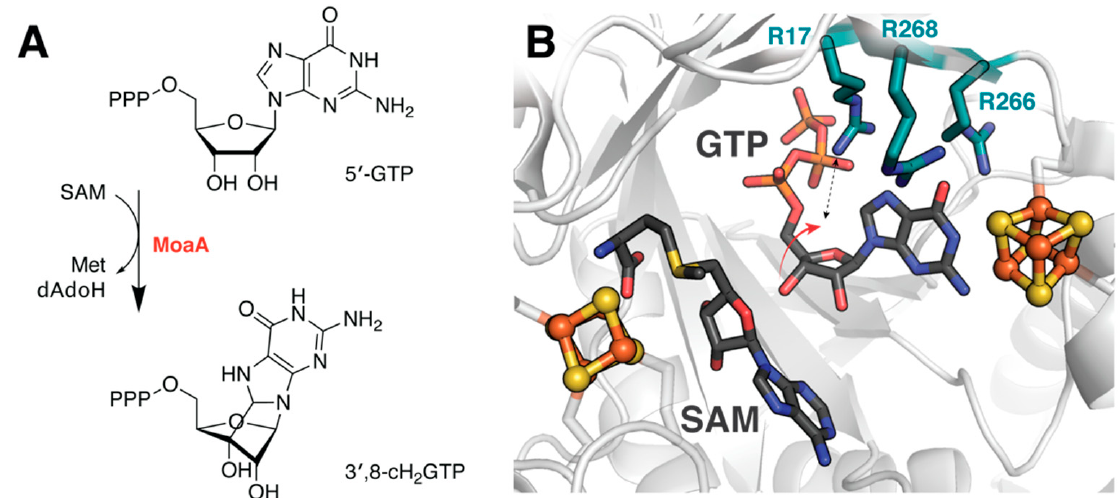
Figure 5. Active site residues facilitate MoaA catalysis. ( A ) Reaction catalyzed by MoaA. ( B ) DFT studies indicate that arginine residues lining the MoaA substrate binding pocket play a role in modulating reaction energetics. These calculations further suggests that reorientation of the ribose moiety enables a key interaction with Arg17 to stabilize the transition state. Structure shown from PDB accession code 2FB3, excluding SAM, which was aligned from 1TV8.